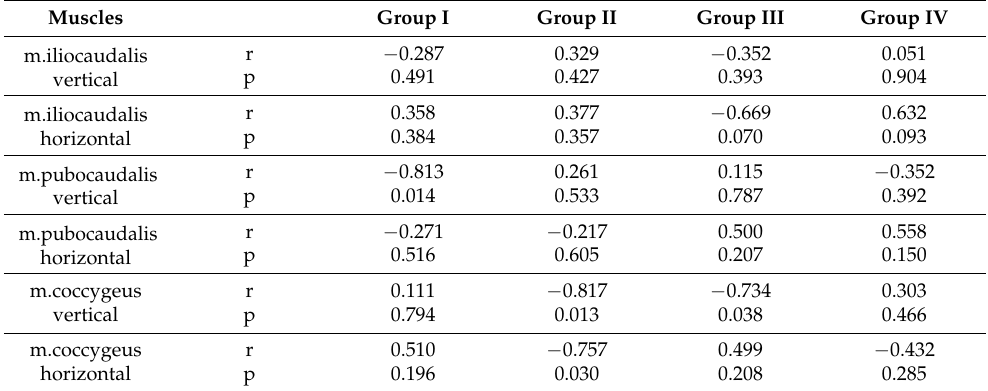
Table 2. Comparison of vertical and horizontal dimensions of muscle body weights.